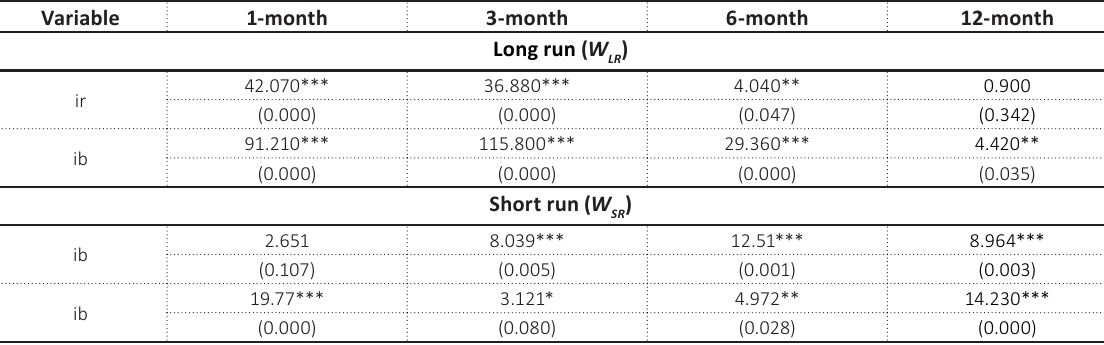
Table 5. Wald test for Long-Run Asymmetric test Variable